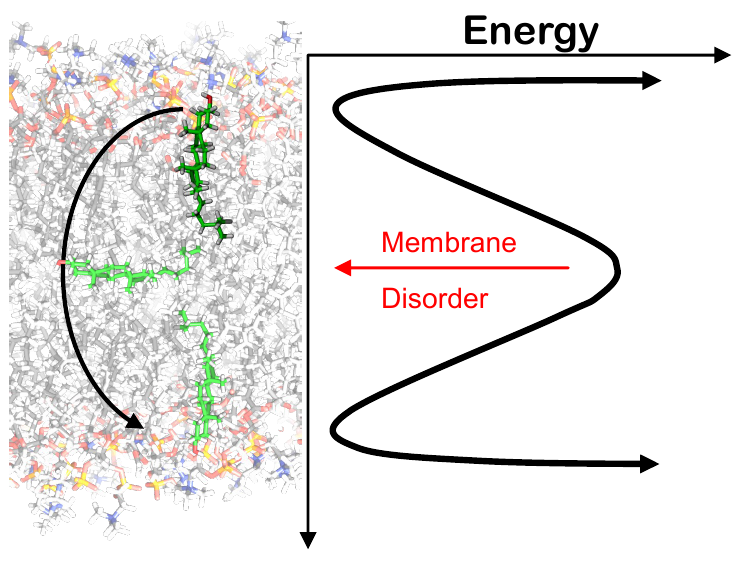
Figure 6. Energy profile for Chol flip/flop. The red arrow indicates that the barrier for flip/flop decreases as membrane disorder increases, as reported in